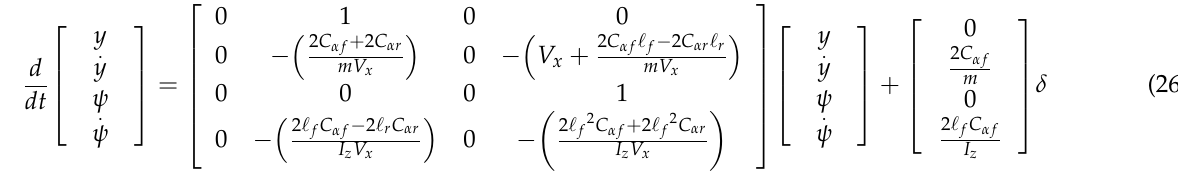
( d ) Figure 4. Membership function of ( a ) speed input; ( b ) navigation input; ( c ) distance input; and ( d ) steering direction output .